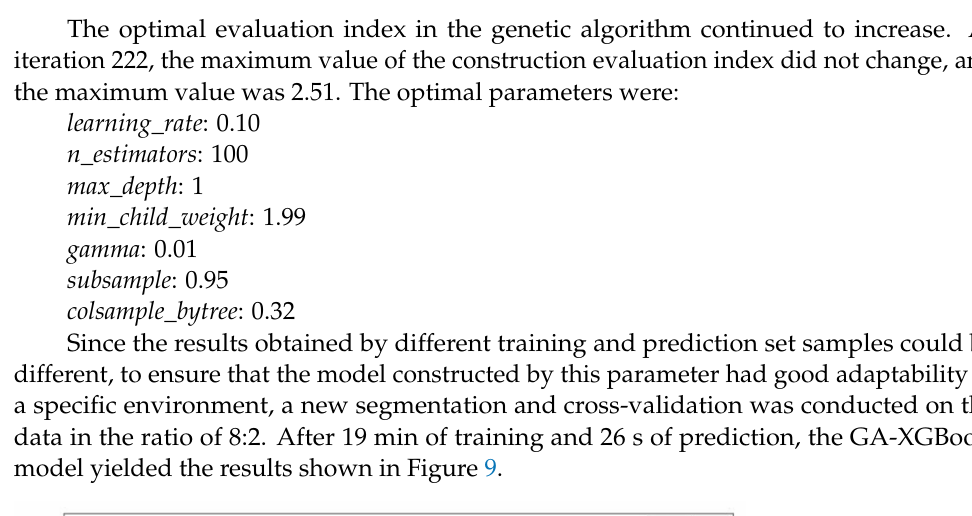
Figure 8. Optimization parameter process of genetic algorithm.